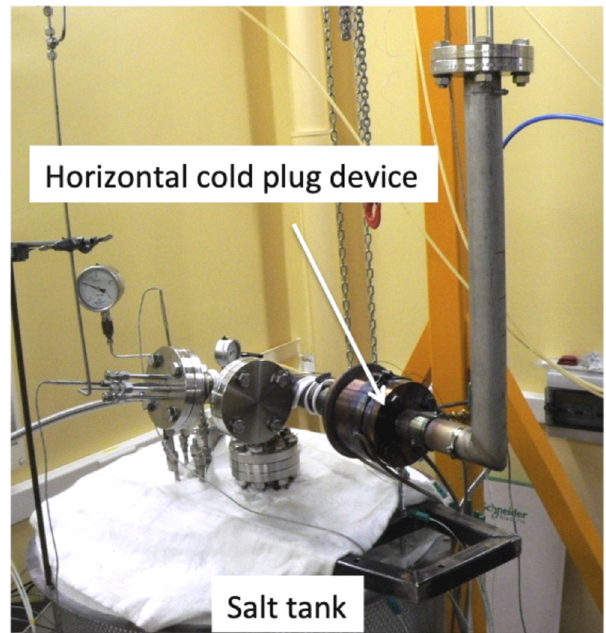
Fig. 3. Con fi guration of the fi rst tests with a simple vertical pipe instead of the loop